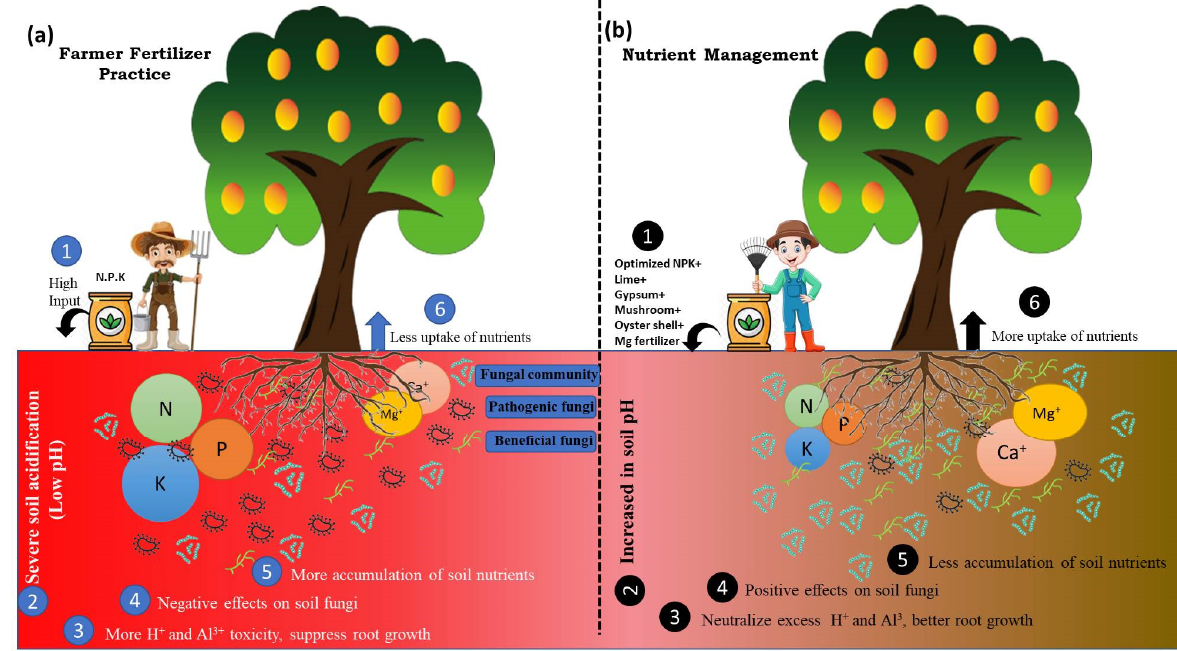
Figure 8. Conceptual framework for explaining how soil properties and fungal communities change under ( a ) farmer fertilizer practice, and ( b ) nutrient management practices.